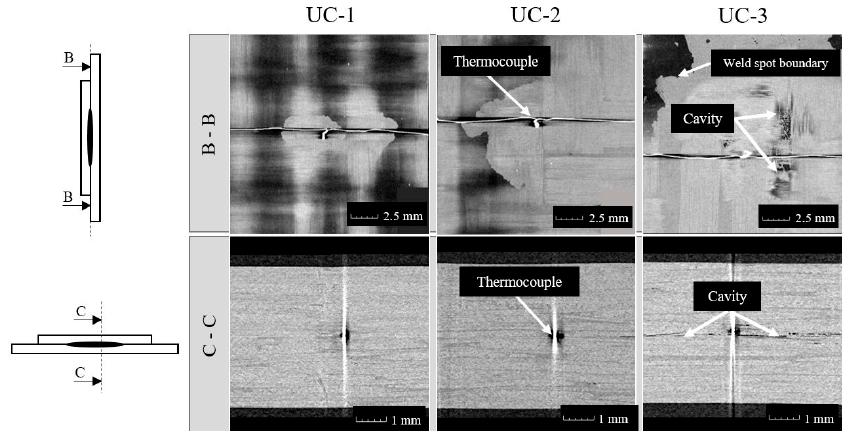
Figure 12. Section images from the computed tomography (CT) scans of three uncontrolled welds. The top sections are at the weld plane (B–B) and the bottom sections are across the weld spot (C–C). The schematic drawings on the left illustrate the location of the sections.